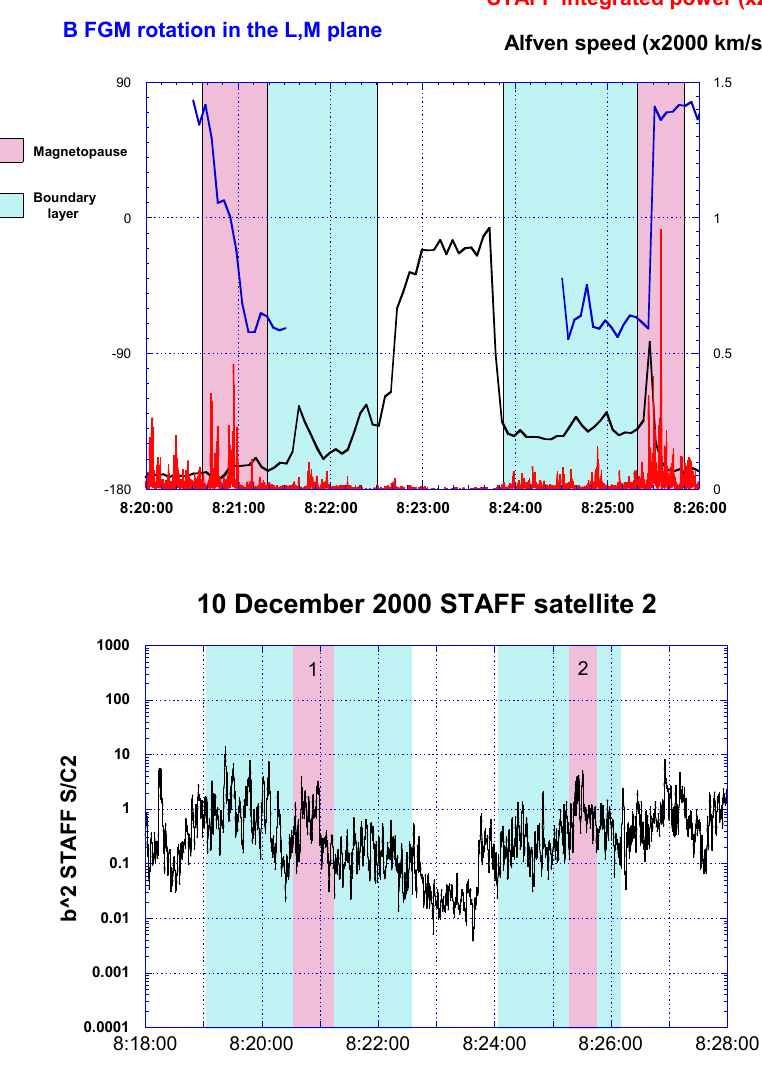
Fig. 4. Power of the fluctuations from the STAFF experiment on spacecraft 2, integrated between 0.1 and